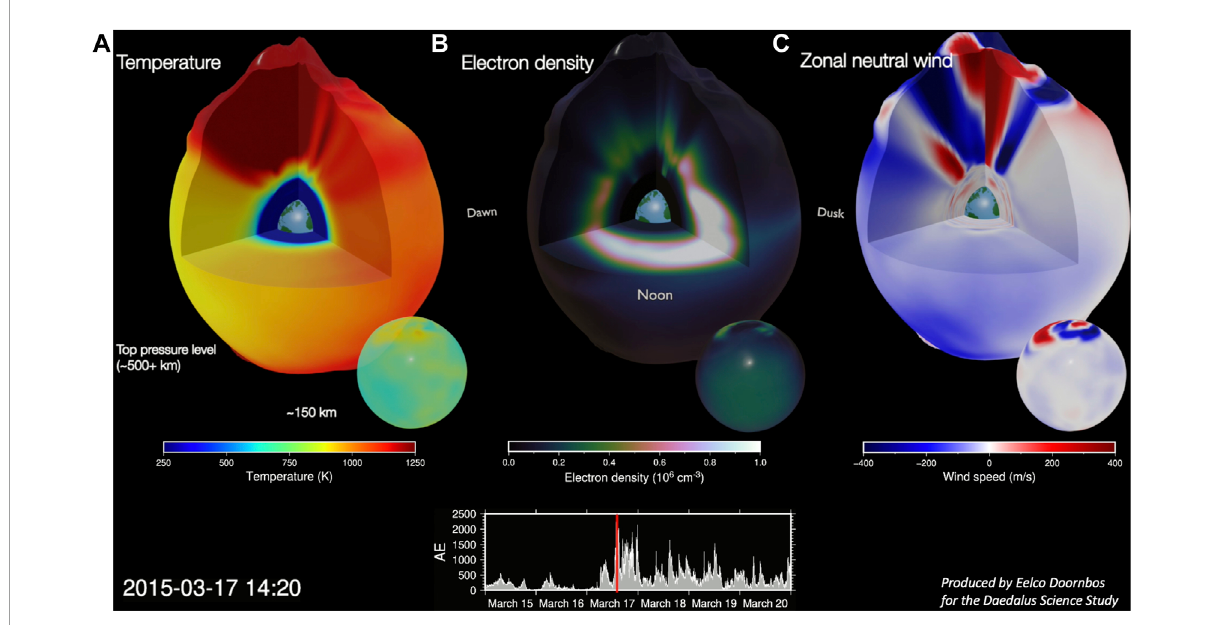
FIGURE 9 3D visualization of GCM model outputs: neutral temperature (A) , electron density (B) and zonal neutral wind (C) . The model output is from the 2015 St. Patrick’s Day storm, showing the simulated state of the atmosphere on 17 March 2015, 14:20 UTC, during a period of significant forcing from above. Pressure level geopotential heights from the model have been exaggerated by 50 times to show vertical detail. Small spheres at the lower right side of each large sphere show the corresponding values at altitudes ∼ 150